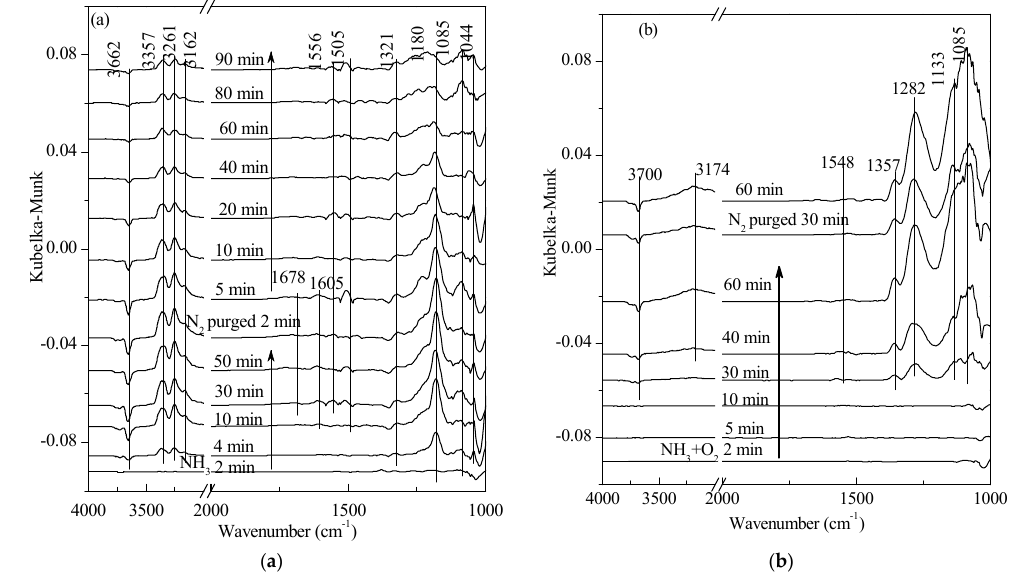
Figure 3. In situ DRIFTS spectra of ( a ) NH 3 adsorption and ( b ) NH 3 + O 2 adsorption on V 2 O 5 -0.2CeO 2 /TiO 2 -ZrO 2 catalysts with N 2 purging for various time at 250 °C after the catalysts were exposed to a flow of 800 ppm NH 3 or 800 ppm NH 3 + 5% O 2 for 60 min.